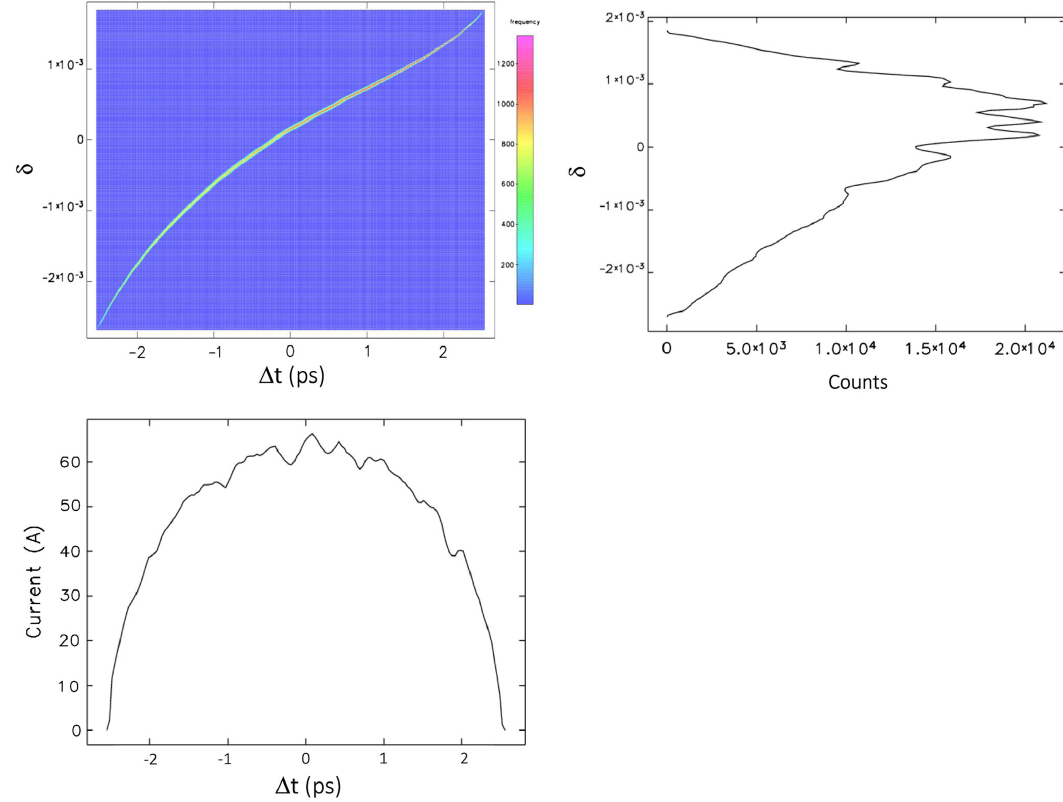
FIG. 6. Electron beam at the entrance of RIBS. Longitudinal phase space (top left), energy distribution (top right) and current profile.